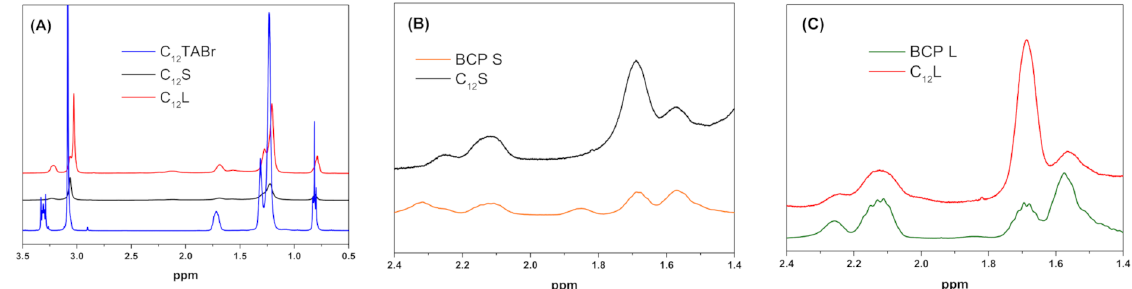
Figure 2. 1 H NMR spectra for intact dispersions compared to spectra for surfactant and block copolymer individual solutions recorded under the same conditions and at the same concentrations as in the dispersions. ( A ) shows comparisons of the surfactant peaks while ( B , C ) compare the block copolymer peaks. The term C 12 denotes the surfactant alkyl chain length whereas S or L refer to the length of the PAAm block in the BCP (short or long,